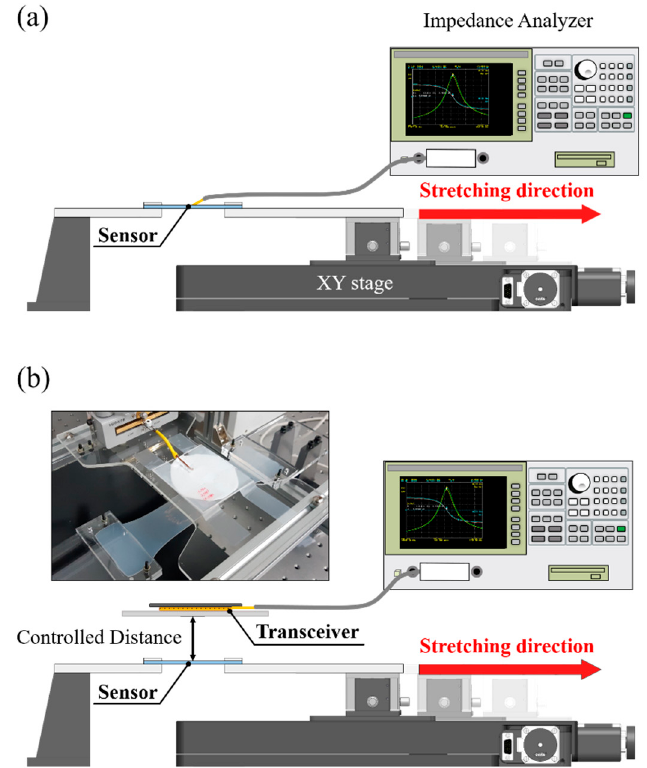
Figure 6. Experimental setup configurations for ( a ) tensile impedance testing and ( b ) wireless sensing.